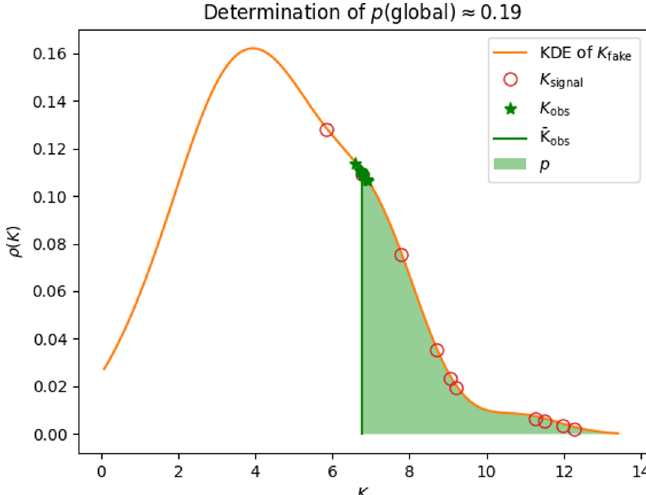
Figure 9 . Values of the test statistic K obtained for the walks discussed in the text. The green stars show the results for the 10 runs over the real database, while the red open circles show the values obtained under the “BSM hypothesis” (see discussion in section 5.3). The solid orange curve shows the distribution obtained under the SM-only hypothesis (see figure 6). The shaded green area corresponds to the global p -value for average K from the runs over the real